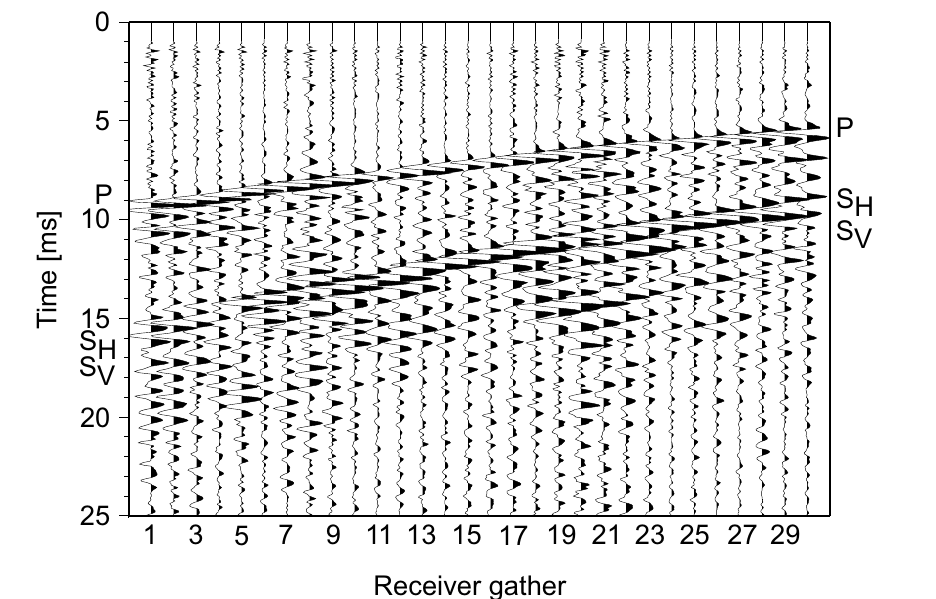
Figure 4. Seismic data of the vertical component at receiver 16 with 30 equidistant shot points in the 30 m borehole. The seismic wave field shows distinct compression (P) and shear (SH, SV) waves and overall a good signal-to-noise